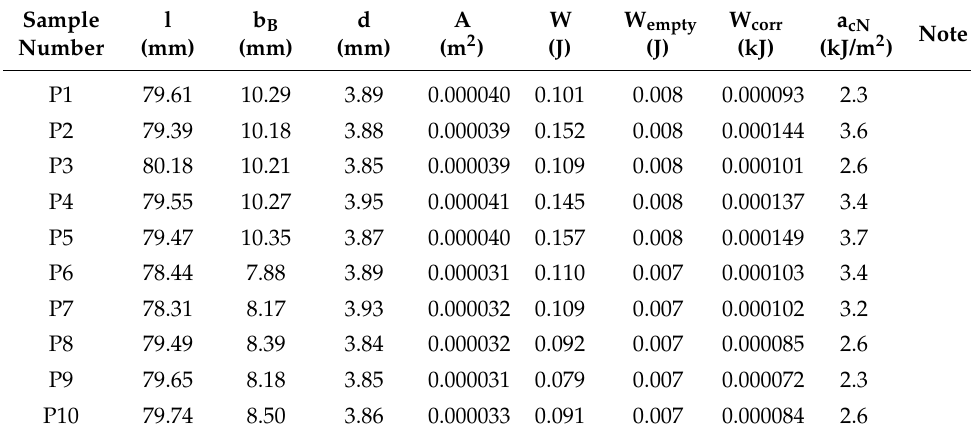
Table A15. Results of the notched impact tests and unnotched impact tests of P_W,PS. Sample